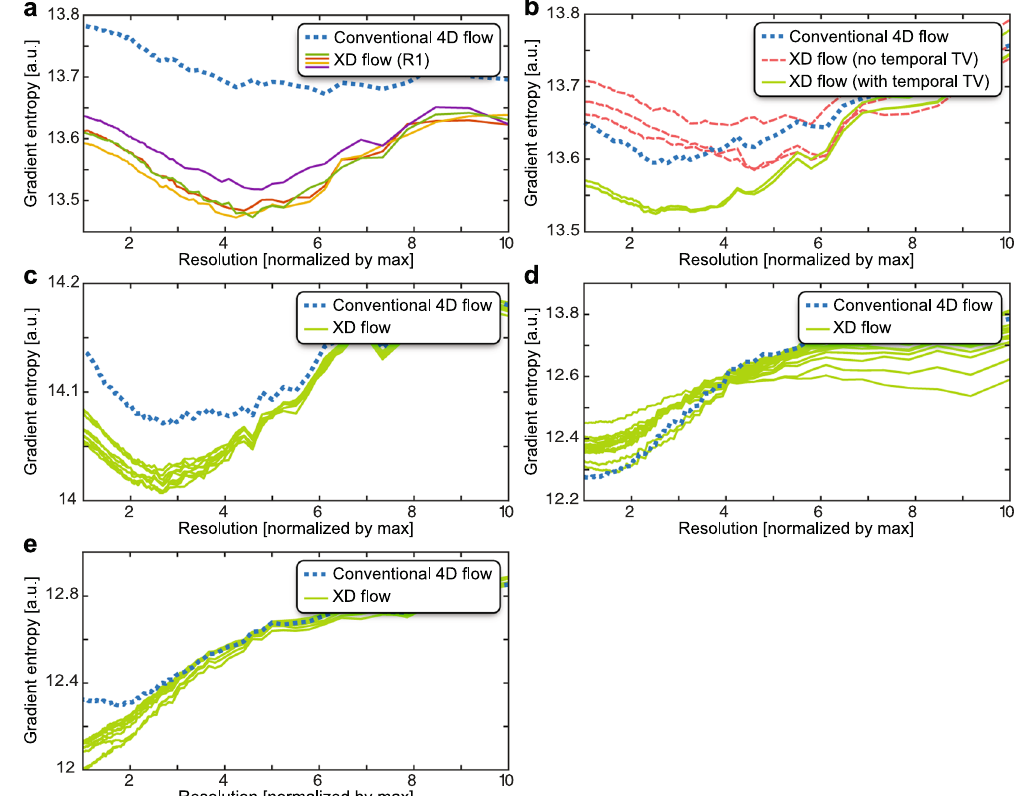
Figure 3. Image sharpness computed using the gradient entropy metric 49 (lower values means sharper images). The spatial resolutions of the final reconstructed images were retrospectively lowered, and this metric was computed as a function of image resolution. In the plots, the resolution is normalized by the maximum resolution — 1 corresponds to the acquired spatial resolution, 2 corresponds to 2x lower spatial resolutions, and so on. The true underlying spatial resolution can be considered as the minimum of the curve. This analysis was performed for each XD flow dataset (green or with corresponding colors of the associated figure) and was compared to the original conventional 4D flow reconstruction (dotted blue): ( a ) subject #1 (Fig. 2) ( b ) subject #2 (Fig. 4) ( c ) subject #3 (Fig. 5) ( d ) subject #4 (Fig. 6), and ( e ) subject #5 (Fig. 7). Compared to conventional 4D flow, sharper images was observed for XD flow that was able to resolve bulk patient motion as plotted in ( a ). In other situations, XD flow resulted in lower image resolutions when resolving high-temporal resolution dynamics compared to conventional 4D flow as plotted in ( d